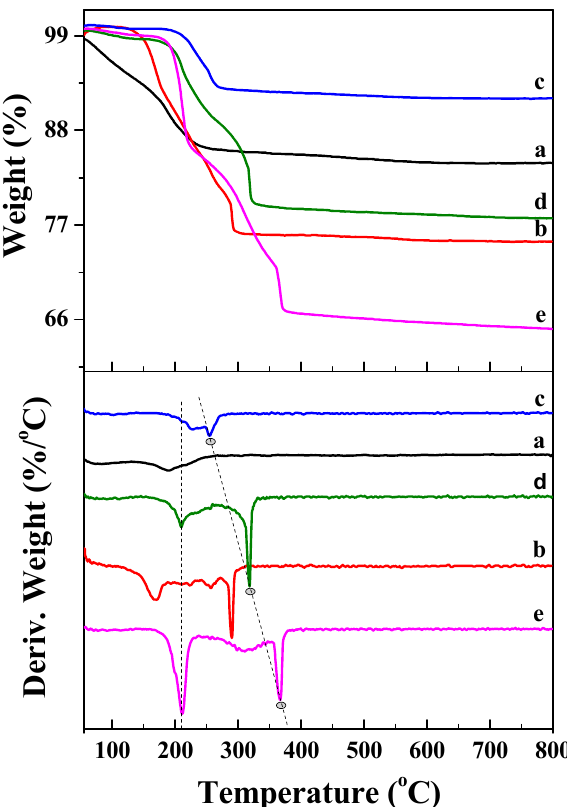
Figure 2. TG and DTG curves of Co / SiO 2 (a), Co-3gly / SiO 2 (b), Co(1gly) / SiO 2 (c), Co(3gly) / SiO 2 (d), and Co(5gly) / SiO 2 (e).